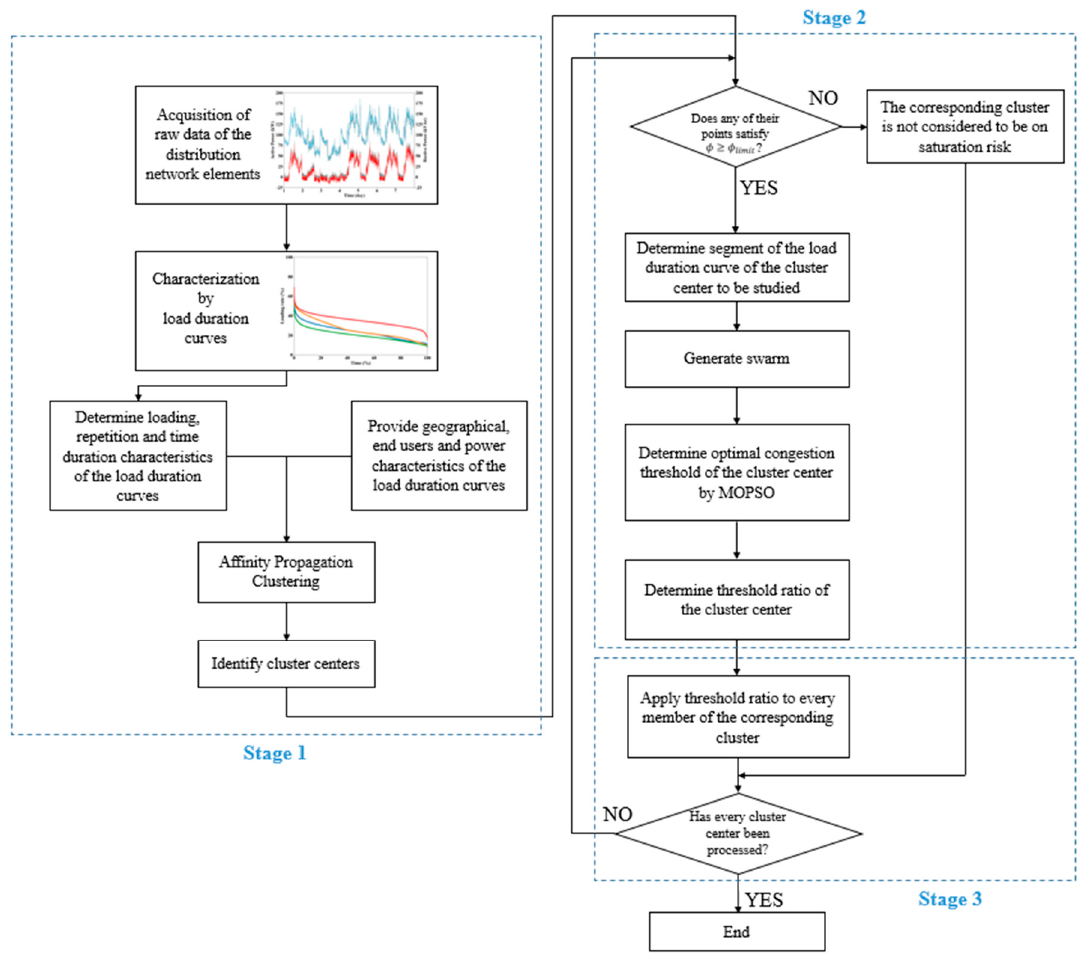
Figure 7. General flowchart of the methodology.